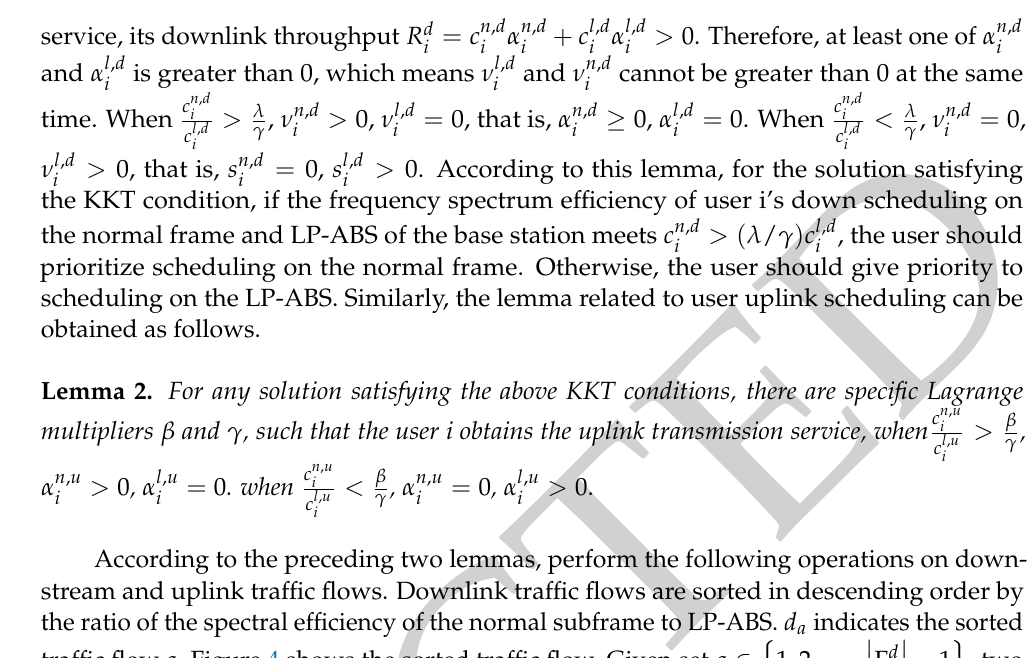
are sorted in descending order of c n , d j